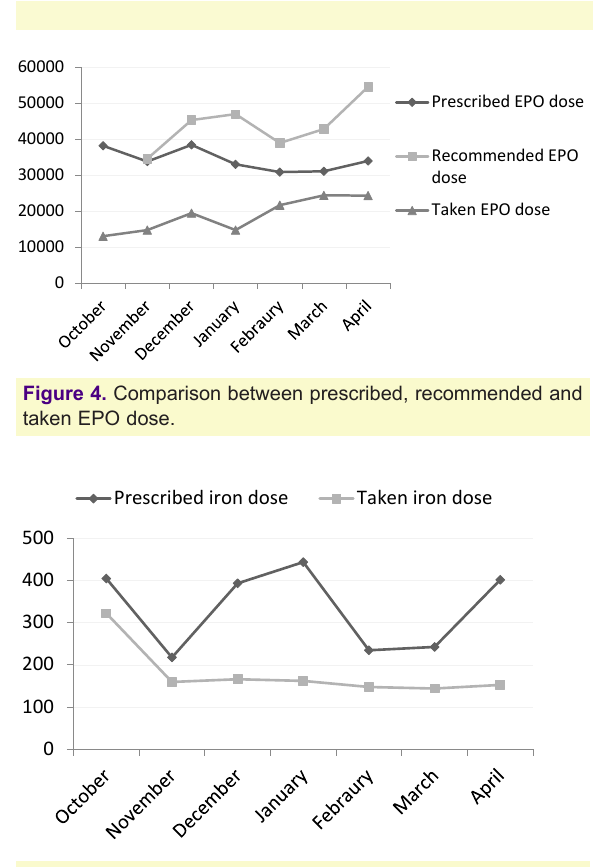
Figure 5. Comparison between prescribed and taken iron doses.